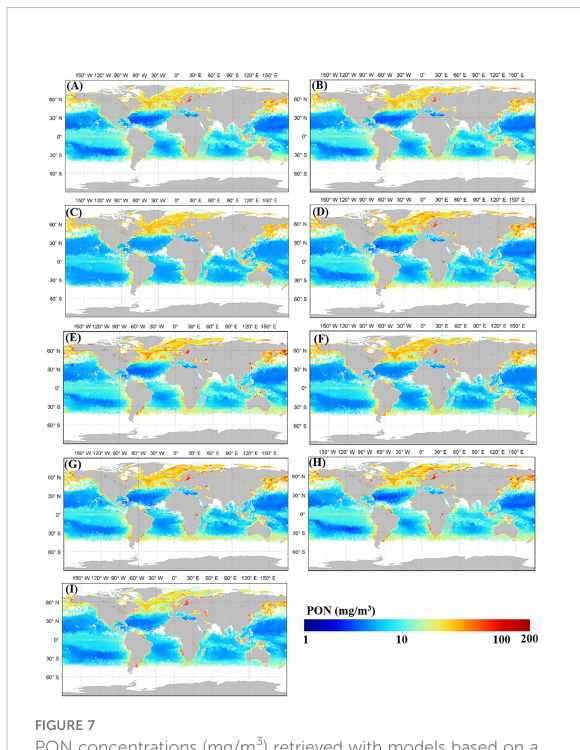
FIGURE 7 PON concentrations (mg/m 3 ) retrieved with models based on